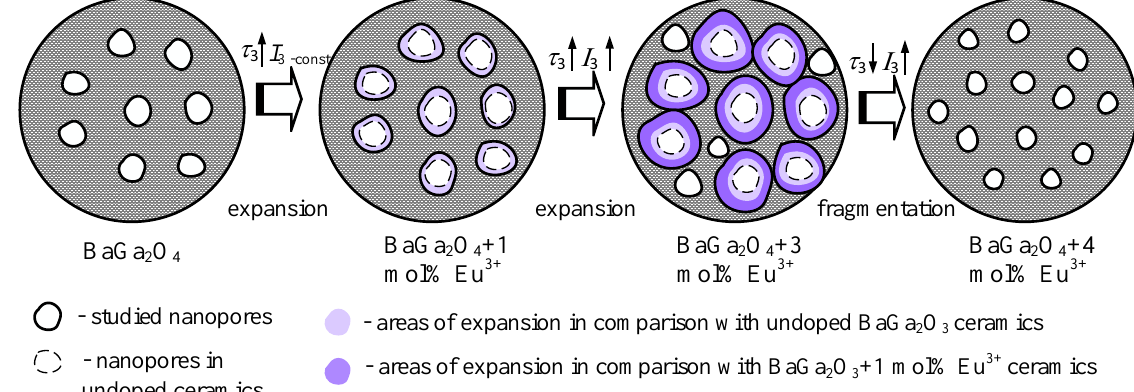
- areas of expansion in comparison with BaGa O +1 mol% Eu 3+ ceramics- nanopores in 2 3 undoped ceramics Figure 5. Diagram explaining the evolution of nanopores in BaGa 2 O 4 ceramics caused by Eu 3+ doping. Adding 1 mol.% Eu 3+ to the BaGa 2 O 4 ceramics is reflected in the increased lifetime of the third component (up to 2.289 ns) at a constant intensity I 3 as compared to the undoped ceramics. This confirms the process of nanopore volume expansion. Further increase in Eu 3+ content up to 3 mol.% facilitates an increase in both lifetime τ 3 and intensity I 3 , pointing at the continuation of the nanopore expansion process with simultaneous new pore creation. However, for BaGa 2 O 4 ceramics with 4 mol.% Eu 3+ ions, the opposite fragmentation process takes place, which can be described as a decreased lifetime of the third component and its increased intensity. Total nanopore volume is smaller than it is for undoped ceramics (see Table 3), thus indicating the excess character of such Eu 3+